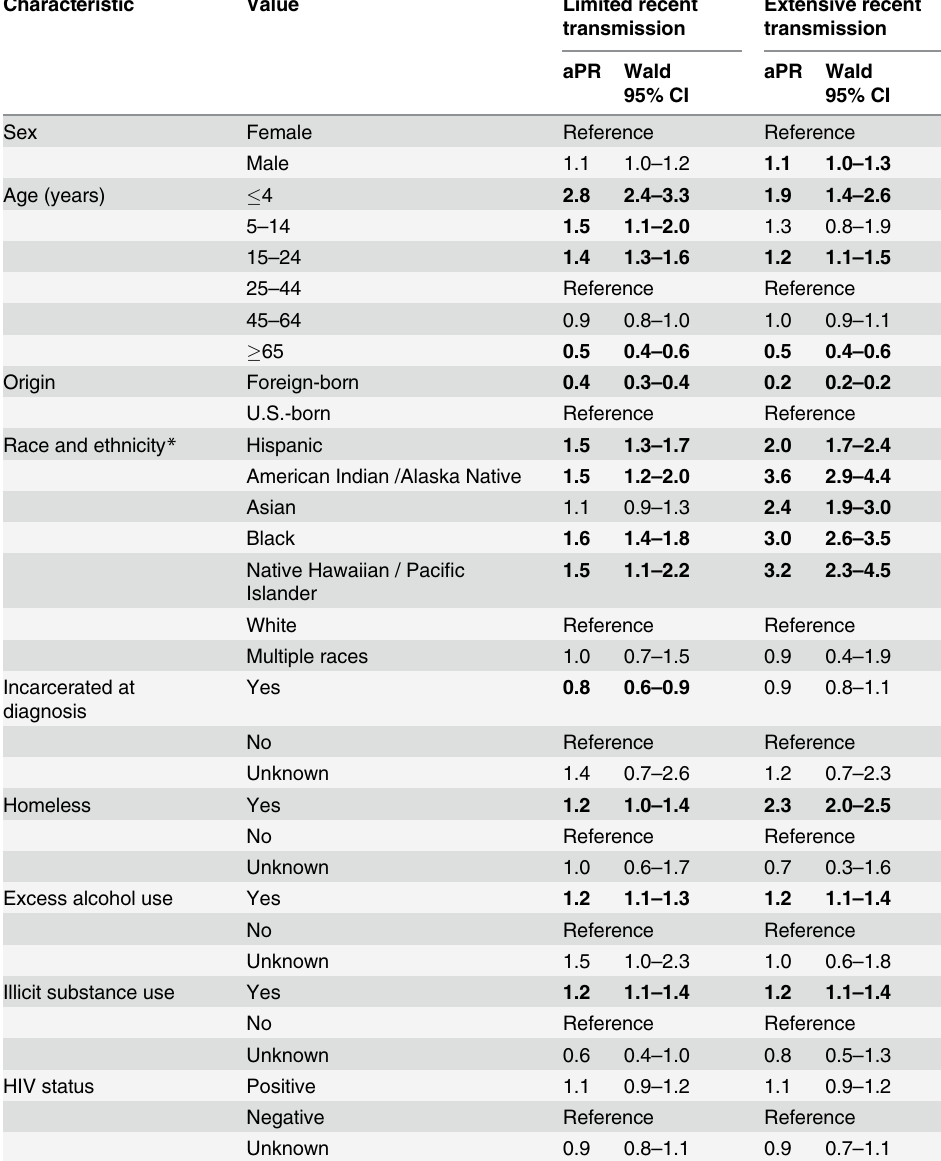
Table 3. Multivariable models for associations between patient characteristics and limited or exten- sive recent transmission.